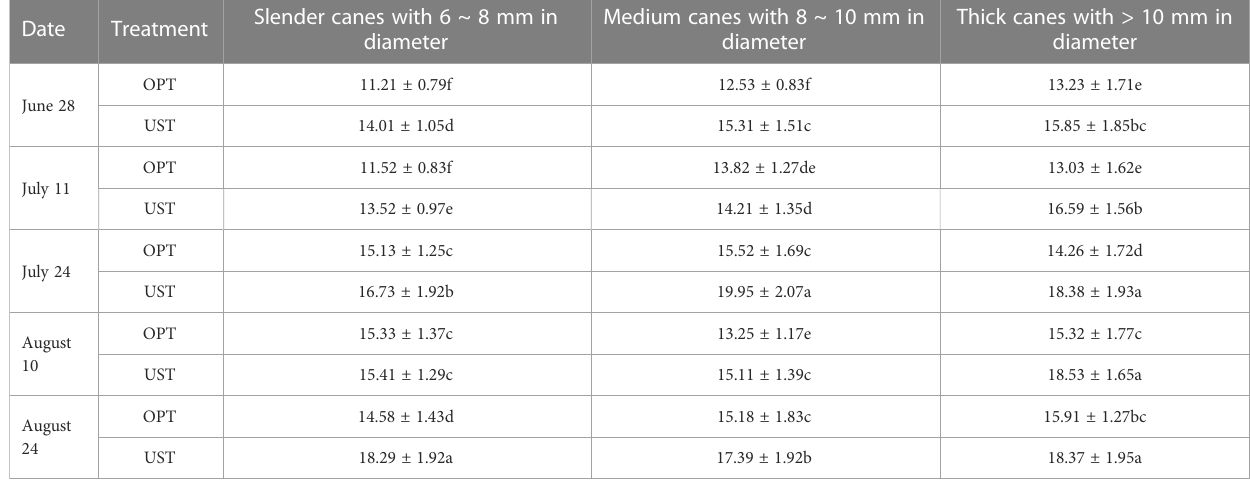
TABLE 4 Effects of OPT and UST on bud number per meter of Donghong